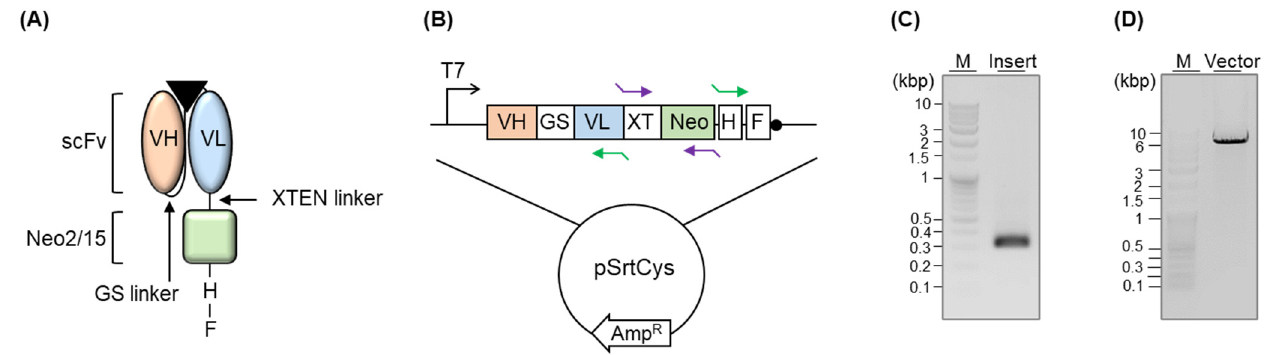
Figure 2. ( A ) Schematic representation of the fusion protein. The triangle indicates an antigen. ( B ) Schematic representation of the DNA plasmid. GS, XT, H, and F indicate the GS linker, XTEN linker, His-tag, and Flag-tag, respectively. Purple arrows and green arrows indicate the primer set for insert PCR and vector PCR, respectively. ( C ) Agarose gel electrophoresis analysis of DNA after the insert PCR. ( D ) Agarose gel electrophoresis analysis of DNA after vector PCR.